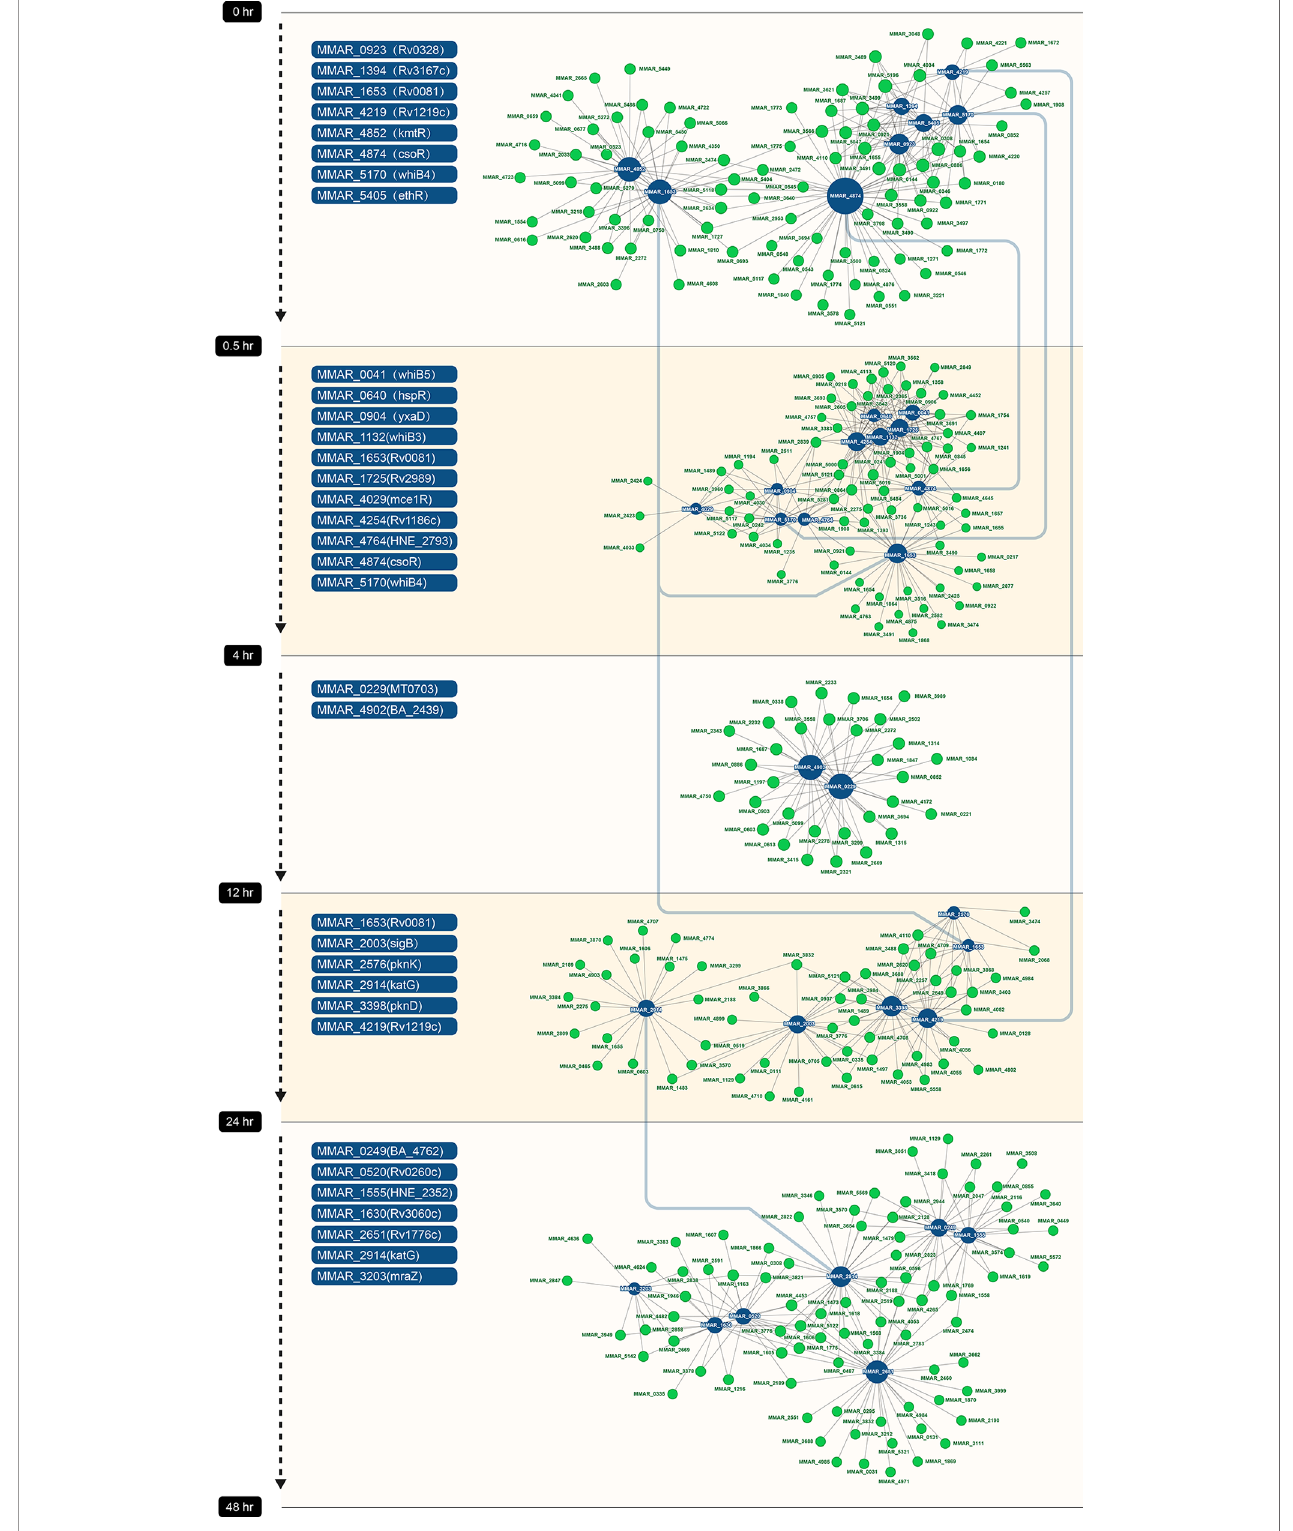
FIGURE 6 | Co-expression networks in fi ve periods. Each dot represents a gene. Transcription factors are labeled in blue, and other genes are labeled in green. Line between dots represents co-expression relationship between genes. The size of dot is proportional to the level of